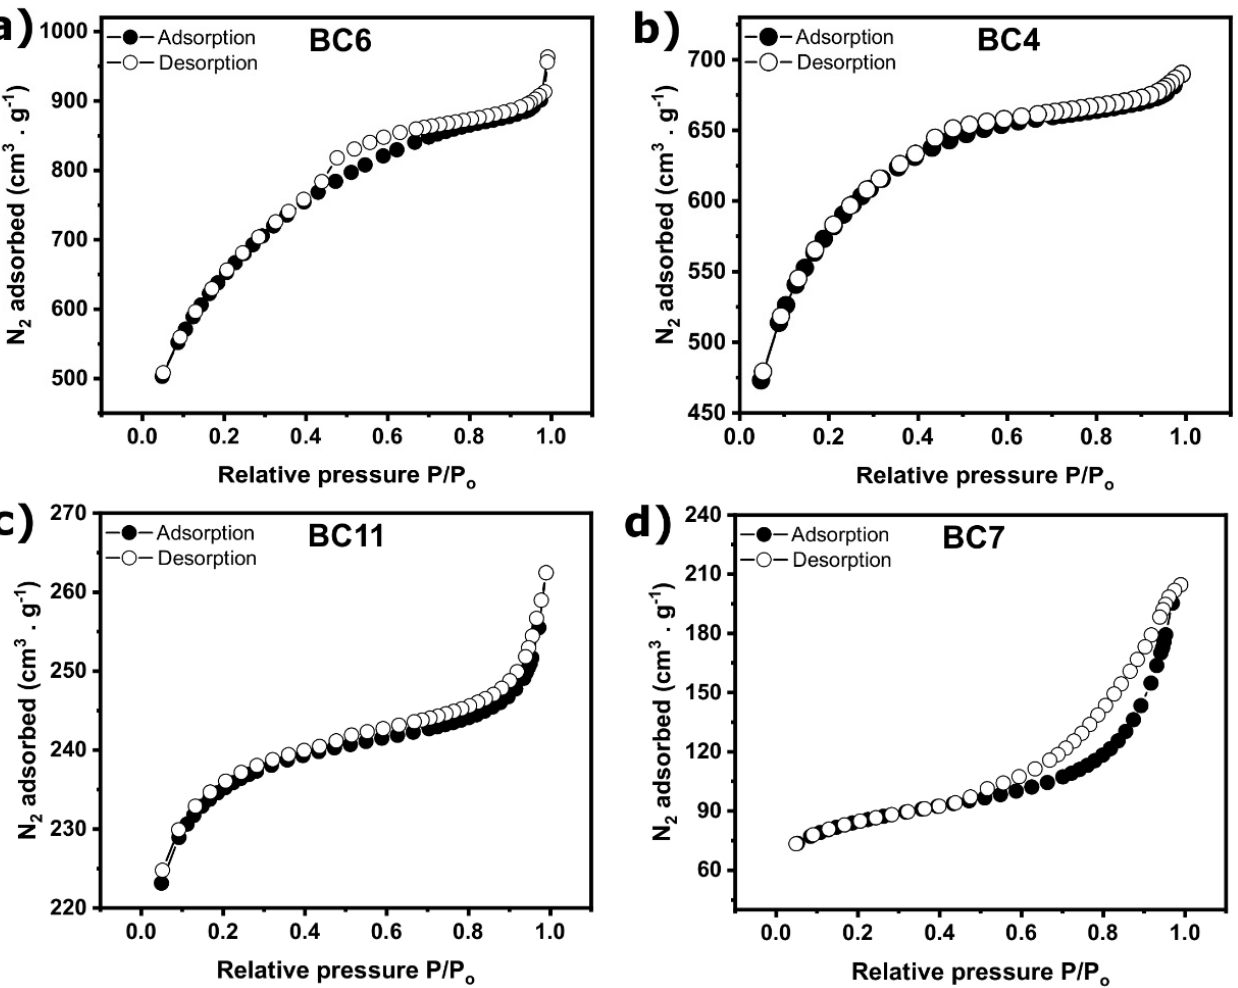
Figure 4. Nitrogen adsorption–desorption isotherms of ( a ) BC6, ( b ) BC4, ( c ) BC11, and ( d ) BC7.